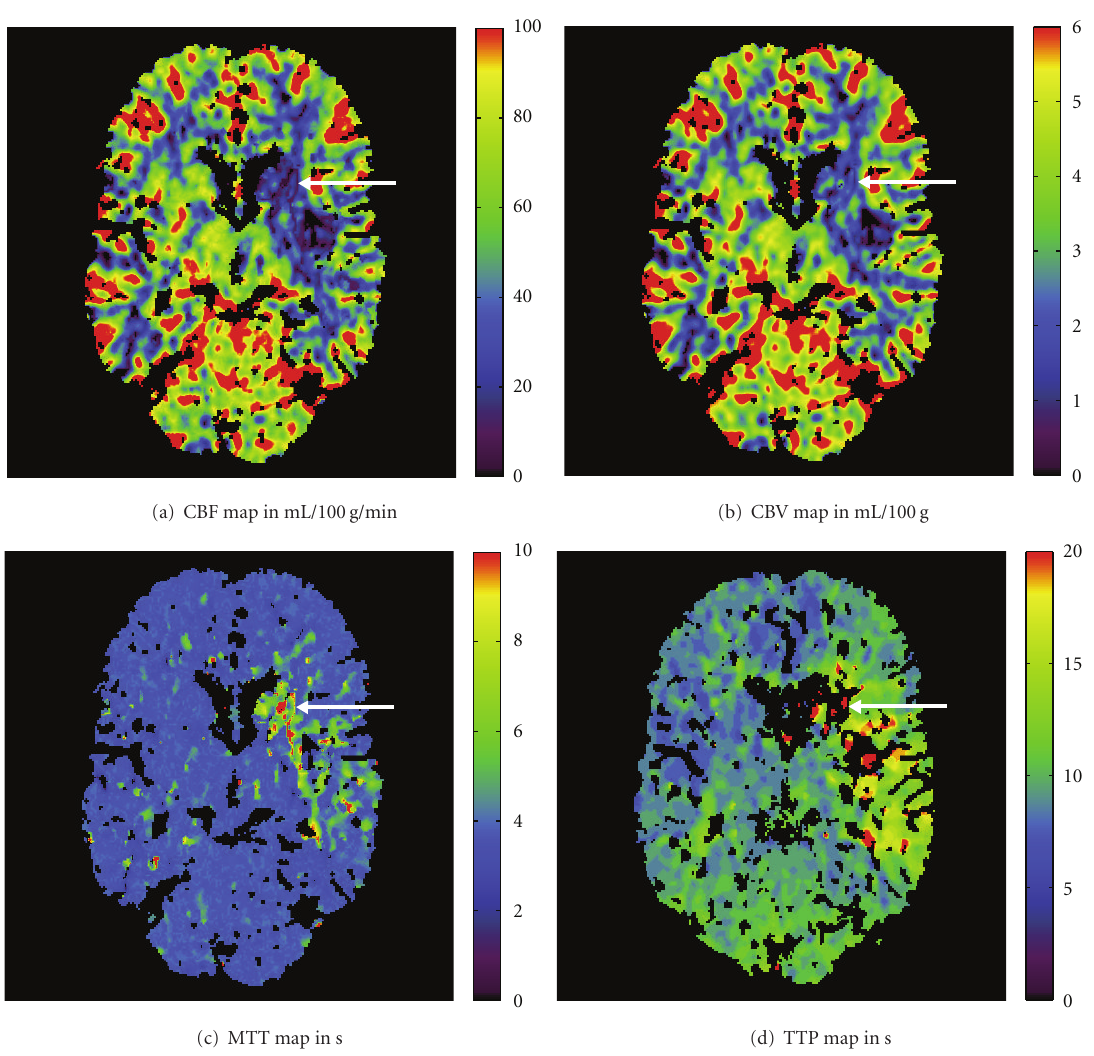
Figure 1: CT perfusion parameter maps of cerebral blood flow (CBF), cerebral blood volume (CBV), mean transit time (MTT), and time- to-peak (TTP). The ischemic stroke lesion is marked with